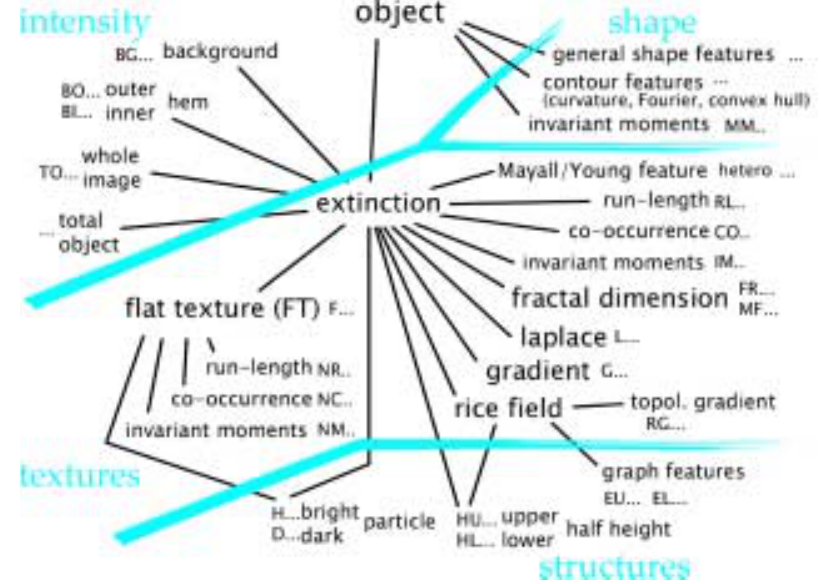
Fig. 2. Overview on all feature groups: Shape, Intensity, Texture, Structures . This figure can be viewed on http://www.esacp.org/acp/2003/